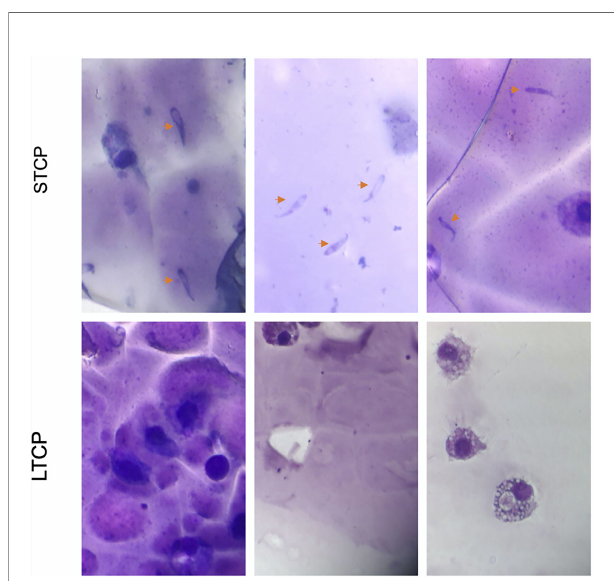
FIGURE 5 | Analysis of animal and tick parameters for B. bovis infections in the tick transmission experiments. Giemsa-stained slides of a representative hemolymph sample to detect kinetes collected from ticks feeding on either C- 1457 or C-1458 animals using 43x power objective of the light microscope. The upper panel represent samples collected from ticks fed on animal C- 1458 infected with S74-T3Bo STCP stabilate. The lower panel represent samples collected from ticks fed on animal C-1457 infected with LTCP strain “ lack of kinetes ”